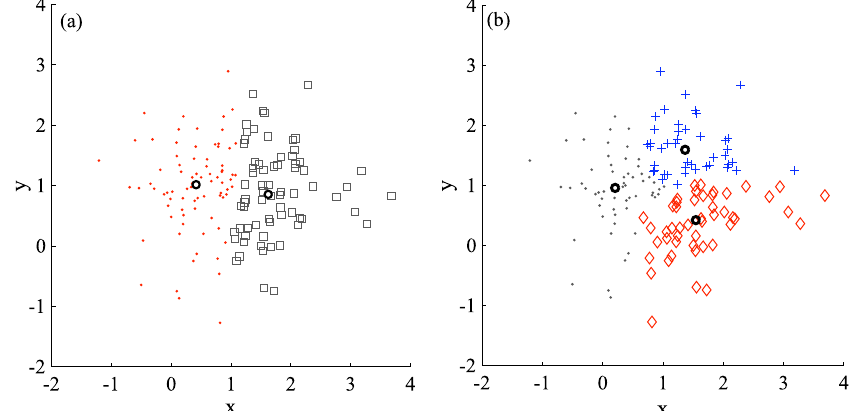
FIG. 2. A set of 150 hypothetical data partitioned into two (a) and three (b) clusters. The mean values of the silhouette function are 0.47 and 0.45, respectively. The x and y axes simply report the values needed to place the points according to their mutual